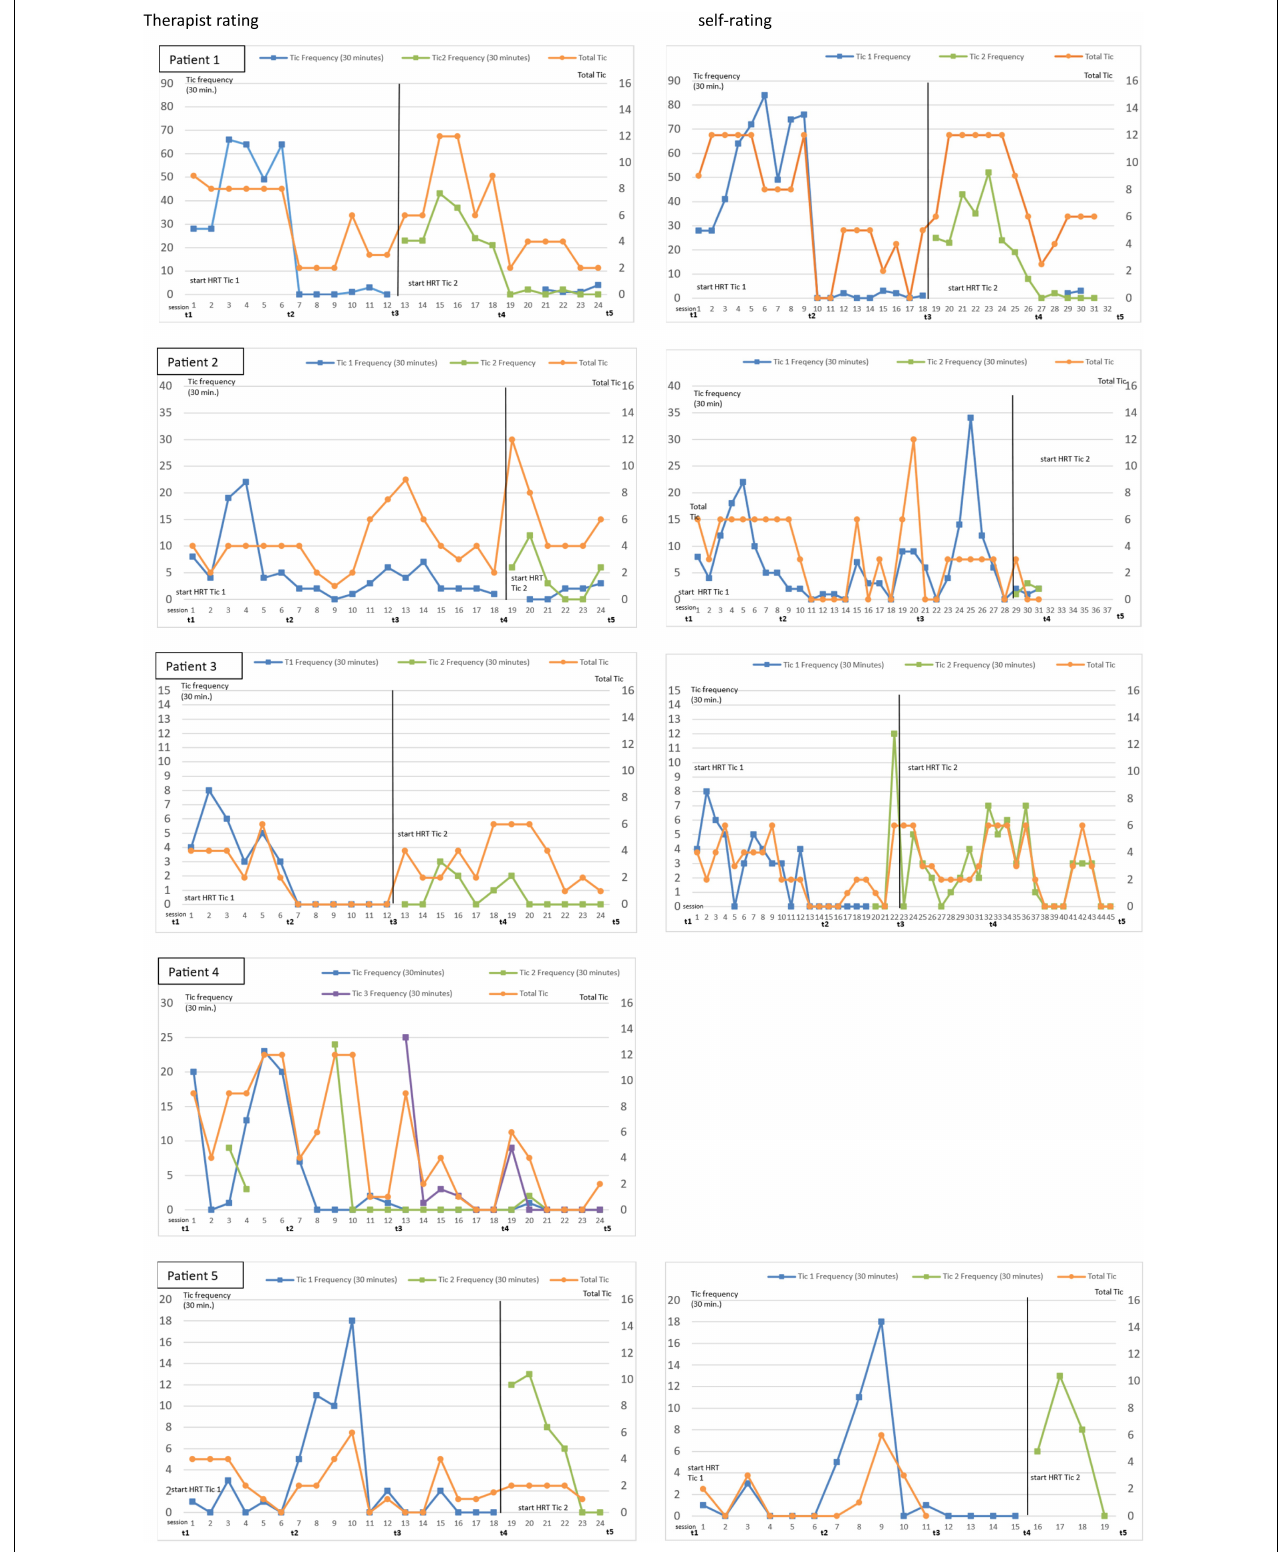
FIGURE 3 | Tic frequency (30 min) in therapist and self-rating during tic training. Self-rating of patient 4 is missing.